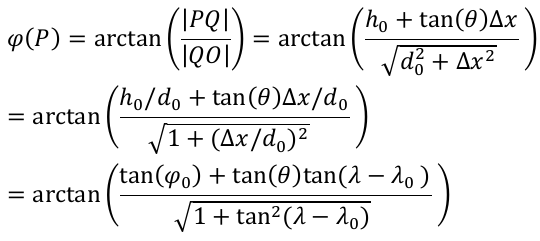
Figure 4 | Top: Grid of horizontal and vertical lines at 15º intervals. Bottom: Sets of parallels with incline equal to 15º, 45º, and 75º. When 𝜑 0 = 0 , the incline of the image at the equator equals the true incline of the spatial line on its vertical